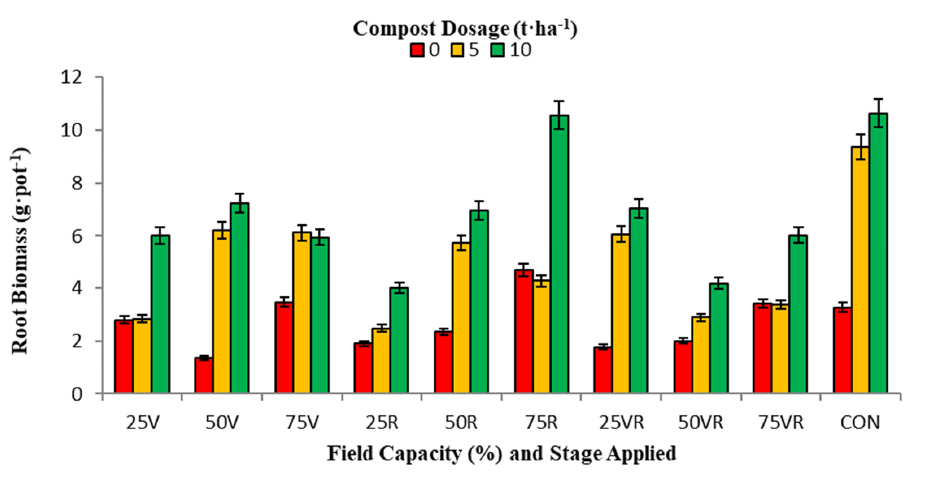
Figure 12. Effect of interaction of water regime, treatment stage and compost dosage on root biomass of okra The 25, 50 and 75% represent field capacity; V (vegetative), R (reproductive), and VR (vegetative and reproductive) represent the stage at which the deficit was applied. Data in the interaction analysed with Least Squares Means, and means separated with